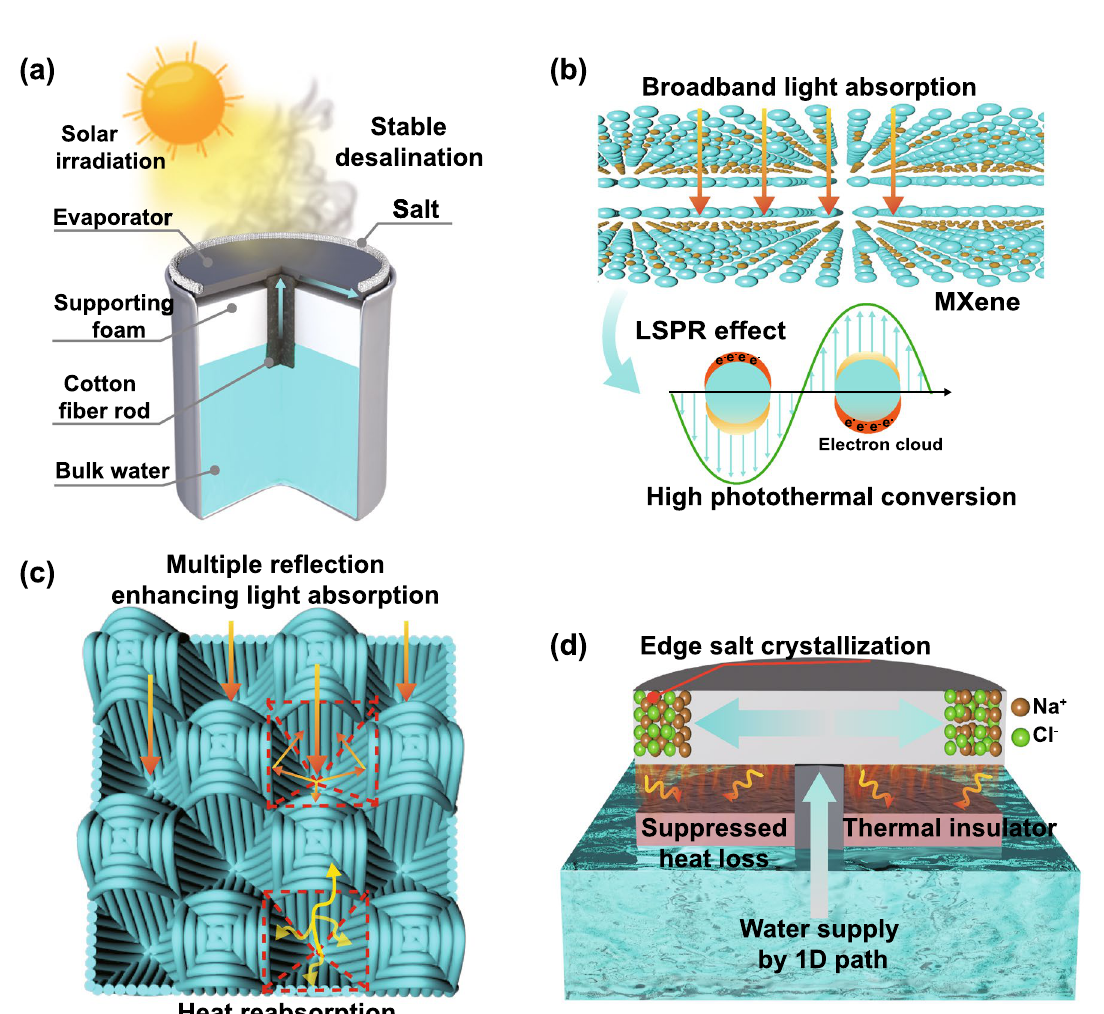
Fig. 1 a Schematic diagram of MXene-decorated 3D honeycomb fabric-based solar evaporator for desalination. b LSPR effect-based photother- mal conversion mechanism of MXene. c Schematic illustration of the 3D honeycomb-structured fabric for light absorption and heat reabsorption. d Schematic diagram of polystyrene foam (for insulation) and cotton fiber rods (for water transport) used to suppress heat loss, salt ring accumu- lation and 1D water